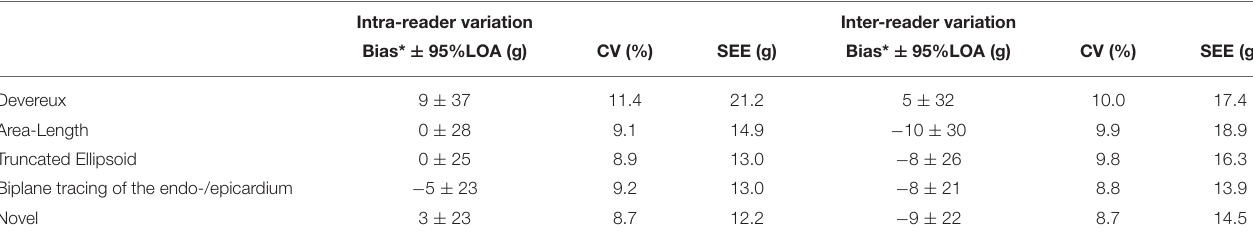
TABLE 4 | Precision (reproducibility) of the various methods for left ventricular mass quantification among the pigs where all measures were available ( n =